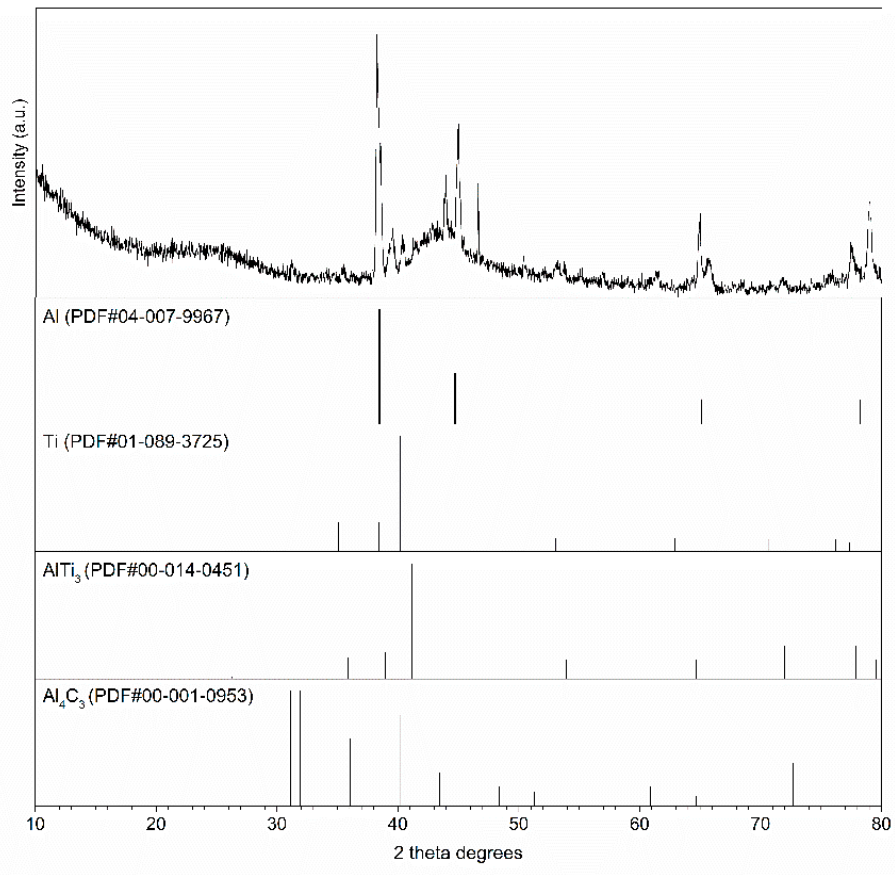
Figure 6. Phase composition of Al-Ti-C system after thermogravimetric analyses at 1200 °C (XRD). The microstructure observations of the created spatial forms of heterophase rein- forcements revealed the influence of the amount of titanium on the quality of the created layer on GC foam. With lower volumes of Ti particle suspension, the created layer was discontinuous and did not cover the whole carbon surface. This phenomenon is presented